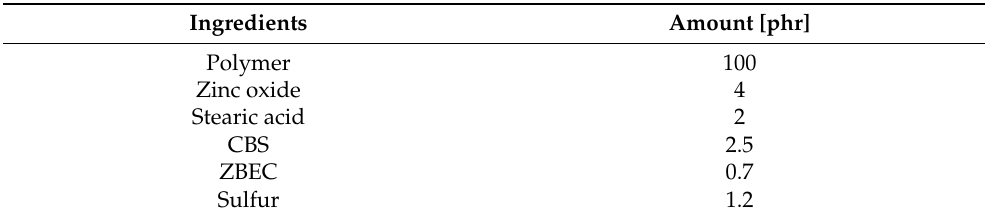
Table 5. The compound formulation for samples with a curing system.